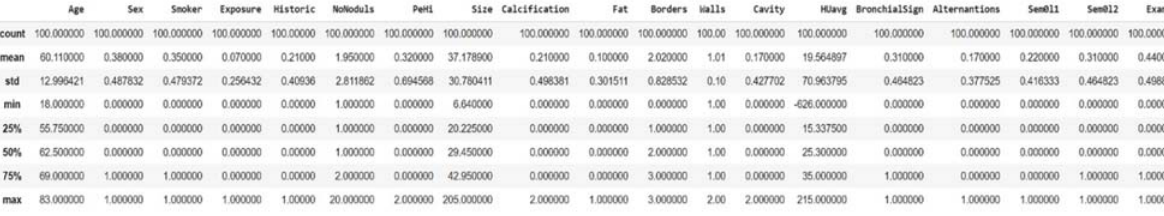
Figure 5. Statistical analysis of the dataset (in Figures 2 and 5, the columns entitled ‘semo011’ and ‘sem012’ correspond to halo sign—referring to part solid ground-glass opacity—and feeding blood vessel sign, respectively) .